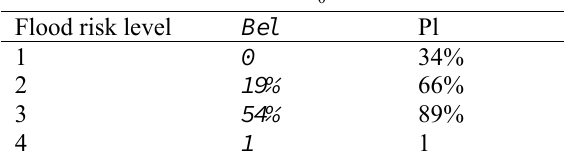
Table 7. Cumulative belief and plausibility functions of E =